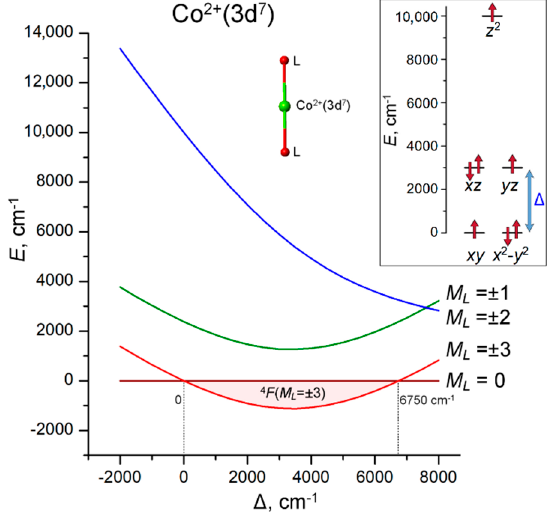
Figure 5. Energies of the 4 F ( M L ) LF states of Co 2+ (3d 7 ) ion in a linear coordination as a function of the energy gap Δ = E ( xz , yz ) − E ( xy , x 2 − y 2). The range of the stabilization of the 4 F ( M L = ±3) ground state (0 ≤ Δ ≤ 6750 cm − 1 ) is marked with light pink. Inset: the LF splitting pattern of 3d orbitals, E ( xy , x 2 − y 2) = 0, E ( z 2 ) = 10,000 cm − 1 (fixed) and E ( xz , yz ) = Δ (variable). LF calculations are performed with atomic parameters B = 750, C = 3800 and ζ = 480 cm − 1 .